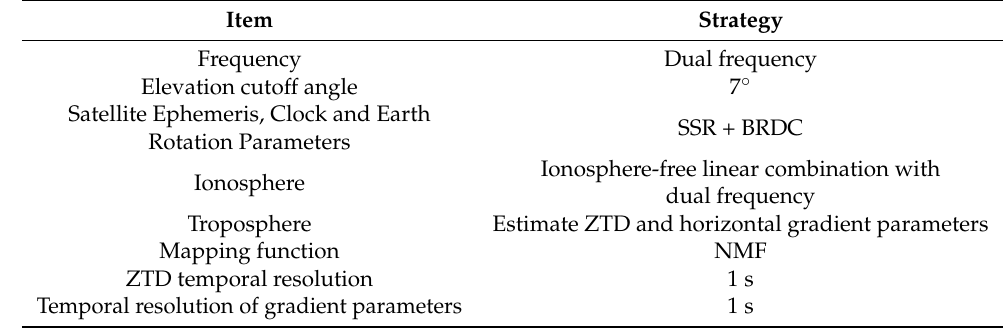
Table 1. Strategy for data processing using the PPP approach. Item Strategy Frequency Dual frequency Elevation cutoff angle 7 ◦ Satellite Ephemeris, Clock and Earth SSR + BRDC Rotation Parameters Ionosphere-free linear combination with Ionosphere dual frequency Troposphere Estimate ZTD and horizontal gradient parameters Mapping function NMF ZTD temporal resolution 1 s Temporal resolution of gradient parameters 1